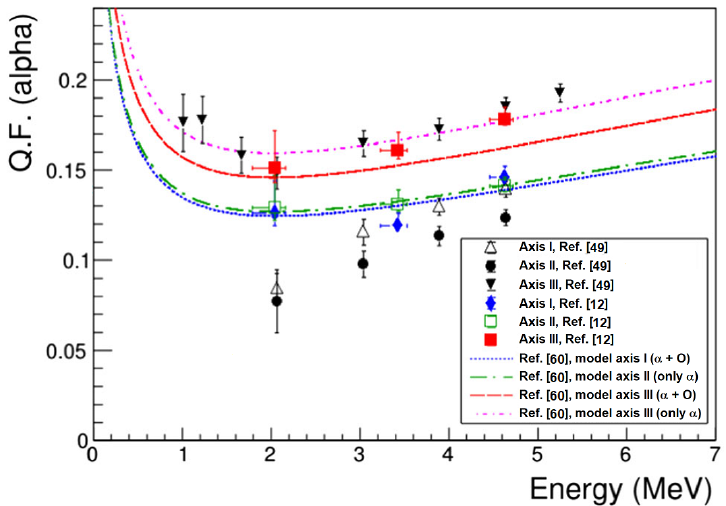
Figure 6. α / γ ratio measured with a ZnWO 4 scintillator in Ref. [12] (colored points) for the three directions of the α beam relatively to the crystal planes and various energies. The values measured in Ref. [49] are also reported for comparison (black points). The anisotropic behaviour of the crystal is evident. The model of Ref. [60] is also reported for each crystal axis. It has been obtained by fitting the data from α ’s and from recoils or only from α ’s. Reprinted with permission from [12]. Copyright 2020 Springer